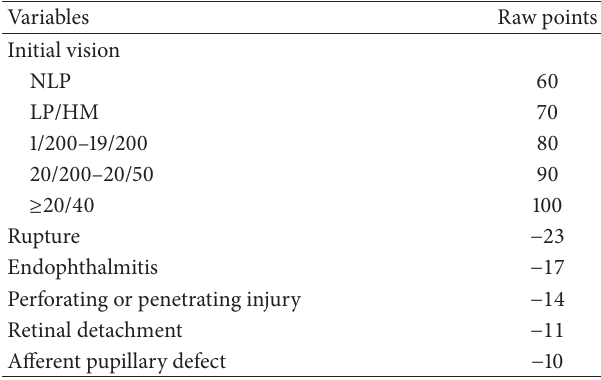
Table 1: The variables and raw points in